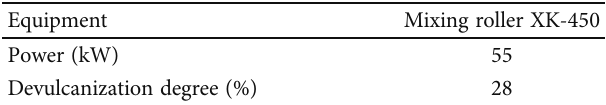
Figure 3: Spectrogram of diatomite. Table 4: Dependence of the devulcanization degree on the power consumption of the